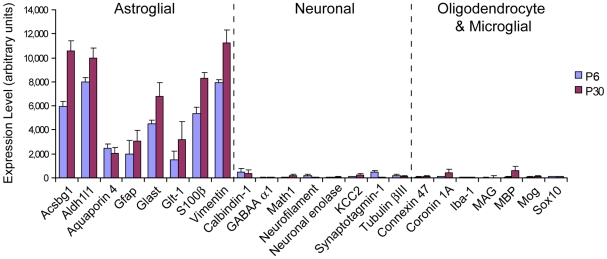
Expression profiles of cell type control genes confirm purity of Bergmann glial cDNA generated by single cell RT-PCR.Mean expression levels of well established markers for astroglia, neurons, oligodendrocytes and microglia were analyzed in the transcriptional profiles of ten Bergmann glia (five each from P6 and P30) using GeneSpring GX 7.3 software. For genes represented by multiple probe sets, the averaged expression of all probe sets were used. Astroglial genes were robustly expressed whereas markers of other cell types were absent or extremely low, confirming the astroglial identity of Bergmann glia and the absence of contaminating mRNAs from other cell types during cell harvesting. Error bars represent ± SEM.